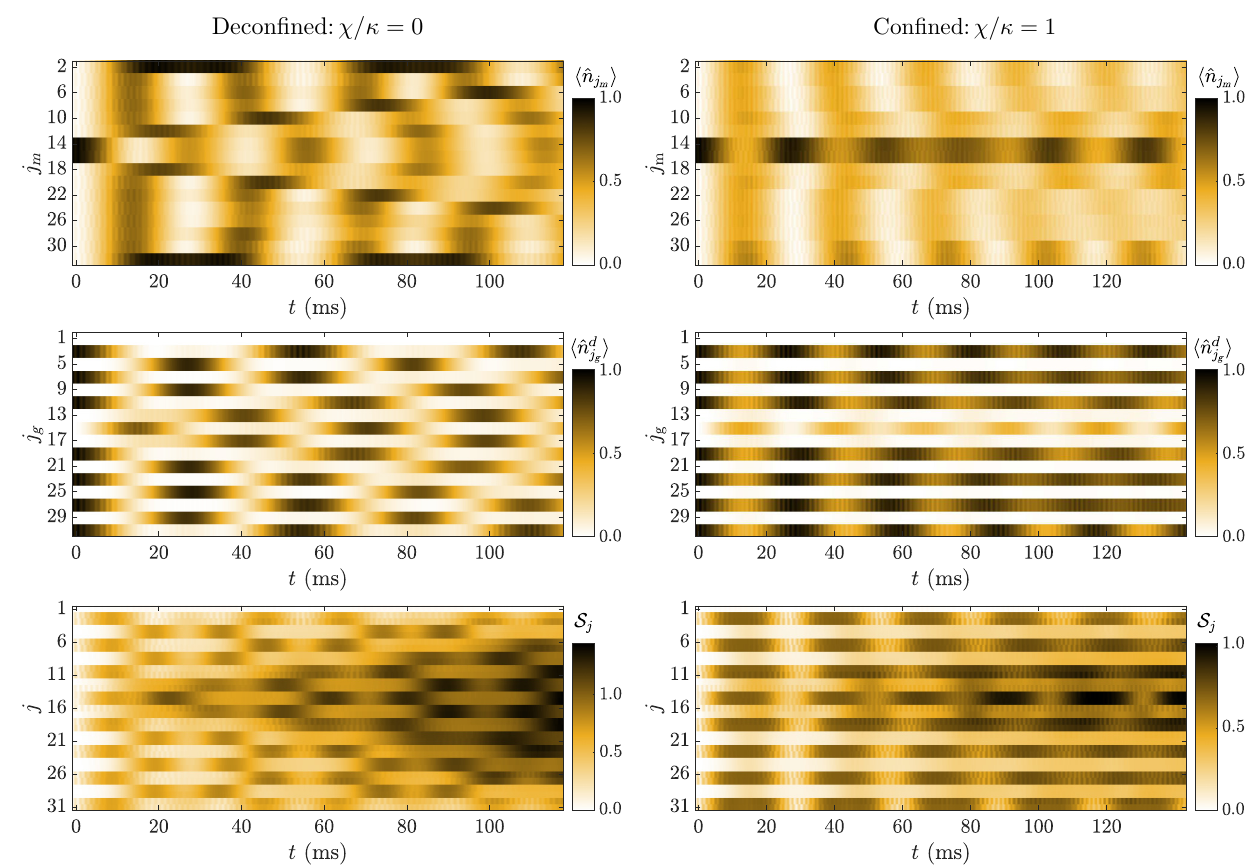
FIG. 9. Dynamics of the electron-positron pair state (see Fig. 2) in the wake of a quench by Hamiltonian (5) at μ/κ = 0, with the strength of the topological θ -term set to χ/κ = 0 (left-column panels) or χ/κ = 1 (right-column panels). Top panels show the quench dynamics of the matter occupation on the even sites of the optical superlattice (where matter fields reside), representing the local chiral condensate. In the deconfined case ( χ/κ = 0), we find clear ballistic dynamics, which can be interpreted as the electron and positron propagating away from each other linearly in time at no energy cost. The dynamics fundamentally changes when χ/κ = 1, where the electron-positron pair is confined, and there is virtually no dynamics. This qualitative picture is confirmed in the dynamics of the site-resolved doublon occupation (middle panels) on odd sites of the superlattice, which represents the local electric flux. Whereas the flipped electric flux between the electron and positron can no longer be distinguished at long times from the electric fluxes at other sites in the deconfined case, when χ = κ confinement stabilizes this flux up to all accessible evolution times. As shown in the bond entanglement entropy in the bottom panels, in the deconfined regime S j ( t ) spreads qualitatively much faster than in the confined regime. It is interesting to note that the confined case allows for longer accessible evolution times in t DMRG due to slower growth in entanglement